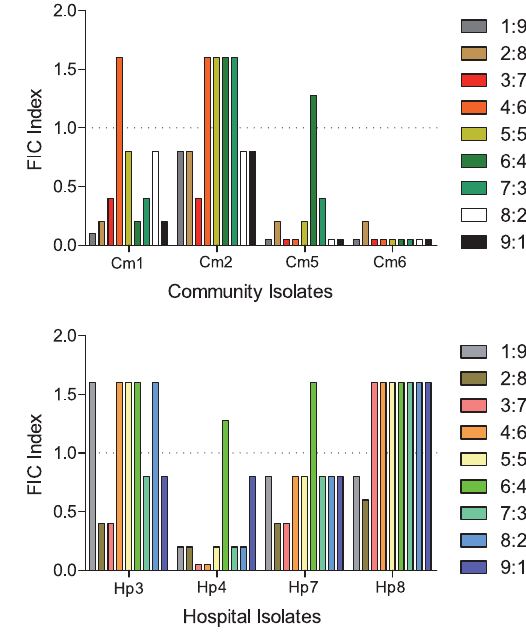
FIGURE 1. Susceptibility of ESBL Isolates to Gentamicin- pe fl oxacin antibiotics cocktail Varying proportions of Gentamicin and Pe fl oxacin antibiotics ranging from 1:9 to 9:1 were mixed according to the continu- ous variation checkerboard method and seeded into Mueller Hinton agar. The ESBL producing organism was streaked on the surface of the agar plate. The set up was done in triplicate with a control containing no antibiotics and these were incu- bated at 37 o C for 24 hours and observed for growth. The MICs of the various combinations were determined and interactions between the antimicrobial agents were assessed by determin- ing their Fractional Inhibitory Concentration [FIC] index ratios where FIC index value below unity signi fi es synergism, ≥ 1 ; indifference, and ≥ 2; antagonism (Cm1, Cm2, Cm5, and Cm6 represent community isolates, while Hp3, Hp4, Hp7, and Hp8 represent hospital isolates respectively).